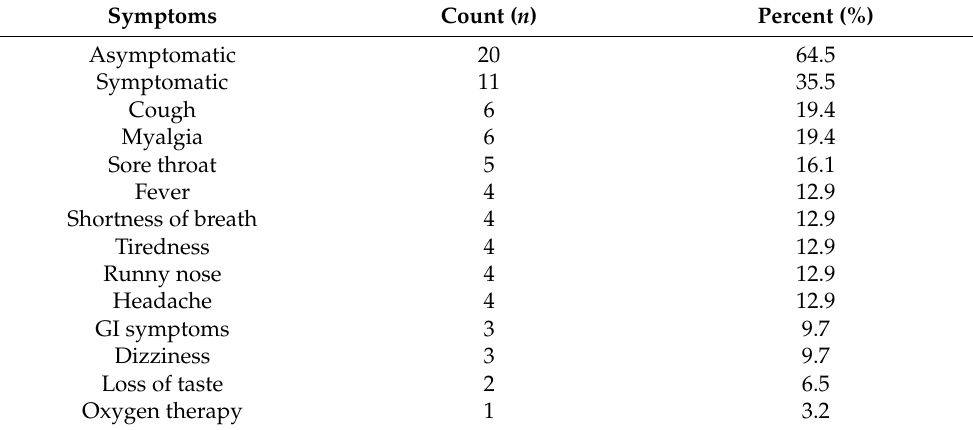
Table 2. Presenting signs and symptoms among the 31 COVID-19 positive